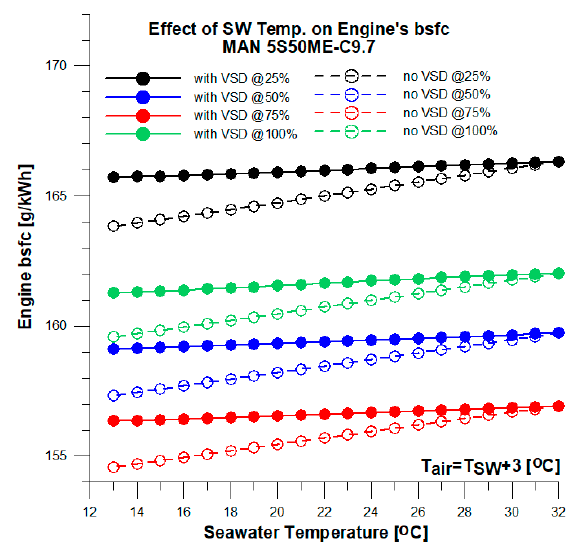
Figure 11. Comparison of the effect of seawater temperature on engine brake specific fuel consumption (bsfc) [g/kWh] with and without the usage of VSD SW cooling pump at various engine loads.